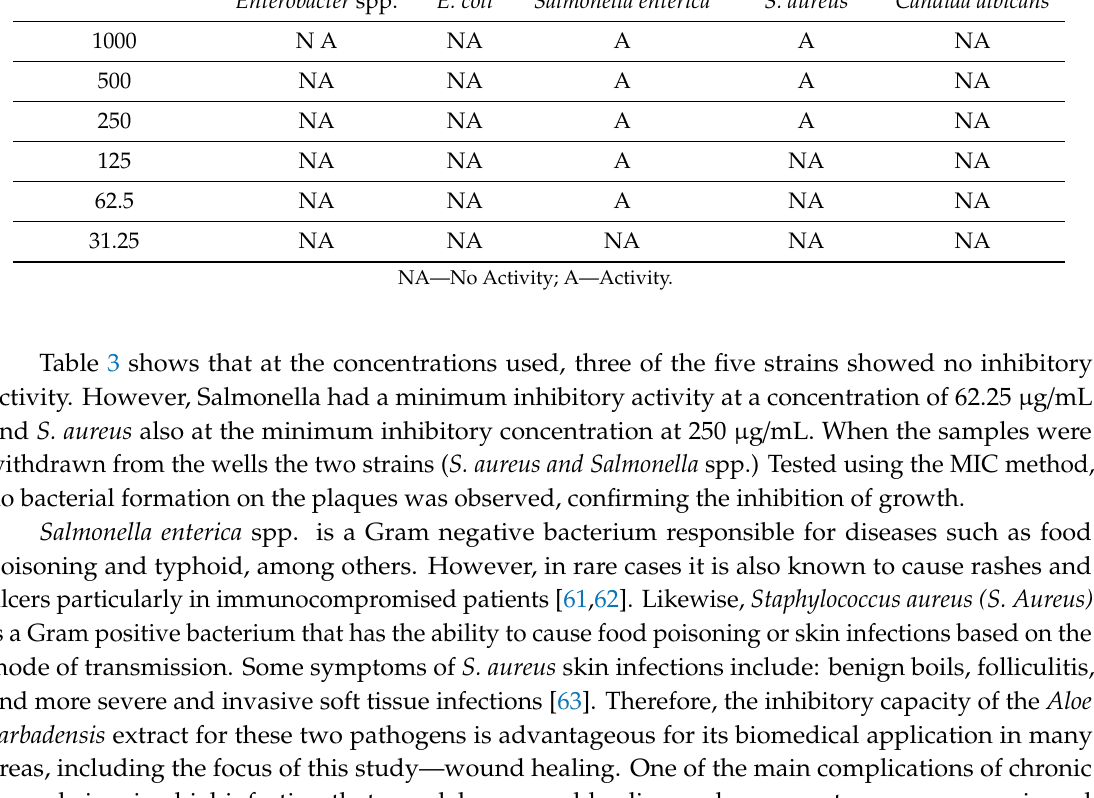
Table 3. Microdilution of Aloe barbadensis extract for the minimum inhibitory concentration (MIC) assay. Microdilution of Aloe barbadensis Gram Negative Bacteria ( µ g / mL) Enterobacter spp. E. coli Salmonella ent é rica Candida albicans 1000 N A NA A A